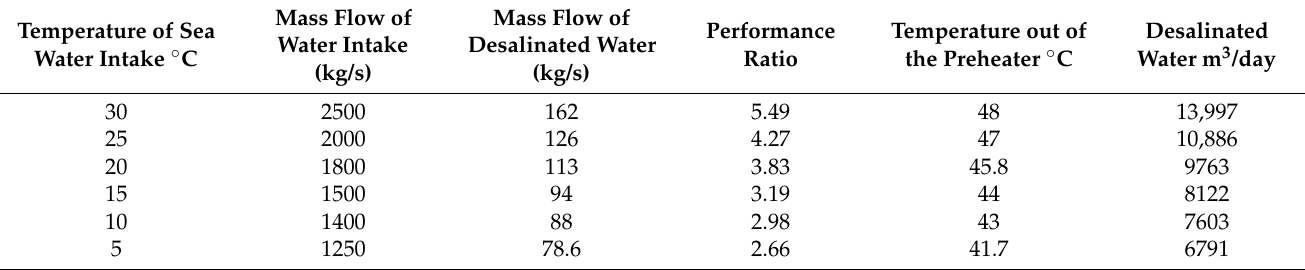
Table 5. Effect of seawater temperature change on the performance of water desalination